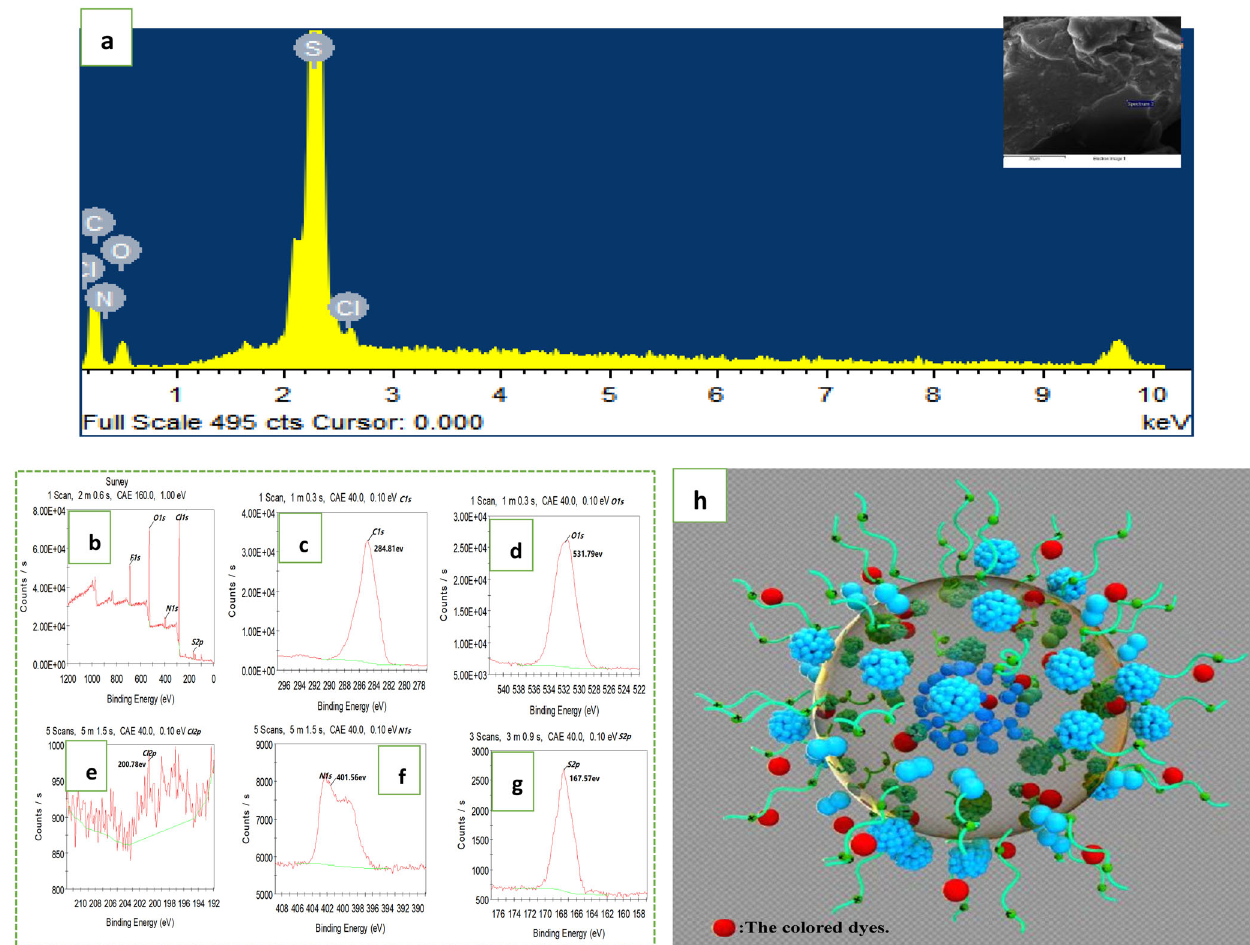
Fig. 8 Deep analysis of interaction behaviors for S/S wastes to adsorb the dyes. a EDS energy spectroscopy analysis of S/S wastes after adsorbing lignins. XPS analysis results of the S/S wastes after adsorbing the dyes: b Survey scanning image, ( c ) scanning the binding energy of C 1 s , ( d ) scanning the binding energy of O 1 s , ( e ) scanning the binding energy of Cl 2p , ( f ) scanning the binding energy of N 1 s , ( g ) Scanning the binding energy of S 2p . h The interaction mechanism model of the S/S wastes used for adsorbing the colored